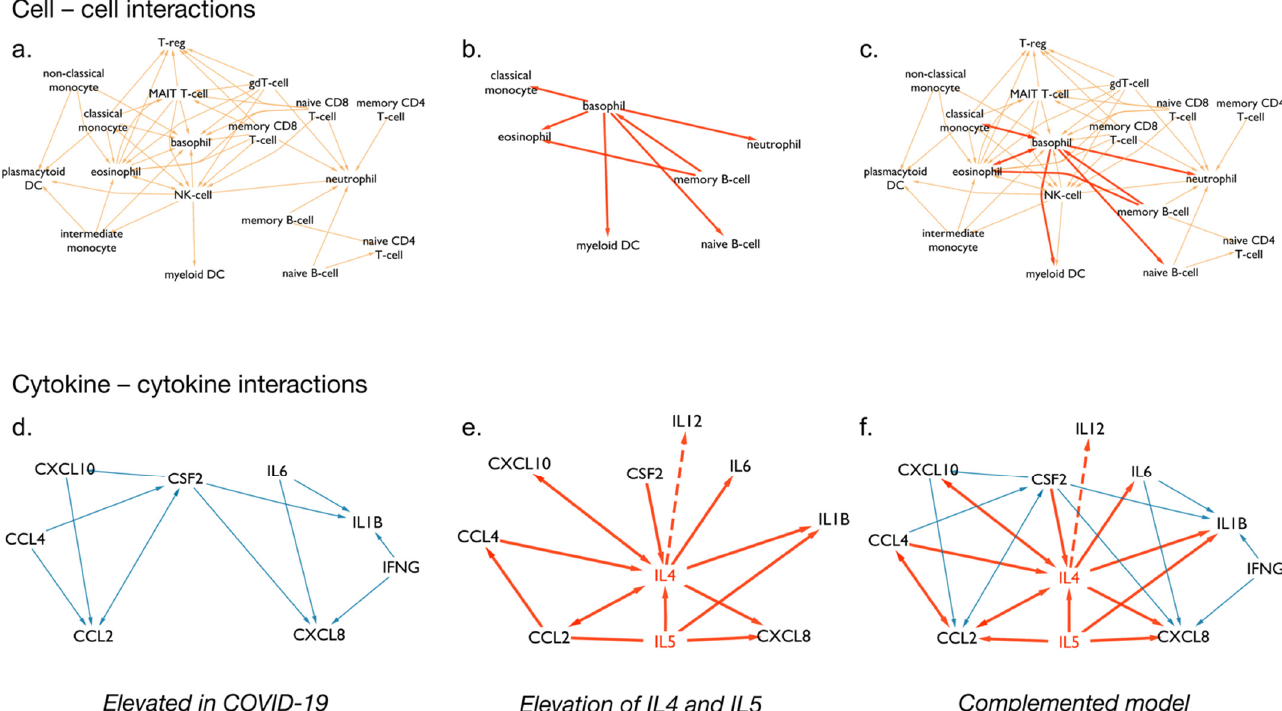
Figure 3. Metanetworks of cytokines increased in COVID-19 patients. ( a ) Intercellular interactions involving cytokines elevated in COVID-19 patients. ( b ) Intercellular interactions mediated by IL4 and IL5. ( c ) Combined intercellular network of cytokines elevated in COVID-19 patients, and intercellular interactions mediated by IL4 and IL5. ( d ) Cytokine–cytokine involving cytokines elevated in COVID-19 patients. ( e ) Cytokine–cytokine interactions involving IL4 and IL5. ( f ) Combined cytokine–cytokine network. The IL4-IL12 interaction is highlighted with dashed lines. IL4 is increased in severe COVID-19, potentially repressing IL12, whose levels are comparable to healthy controls in severe cases [37,38]. Mutual edges were collapsed, shown with arrows on both ends to reduce complexity.